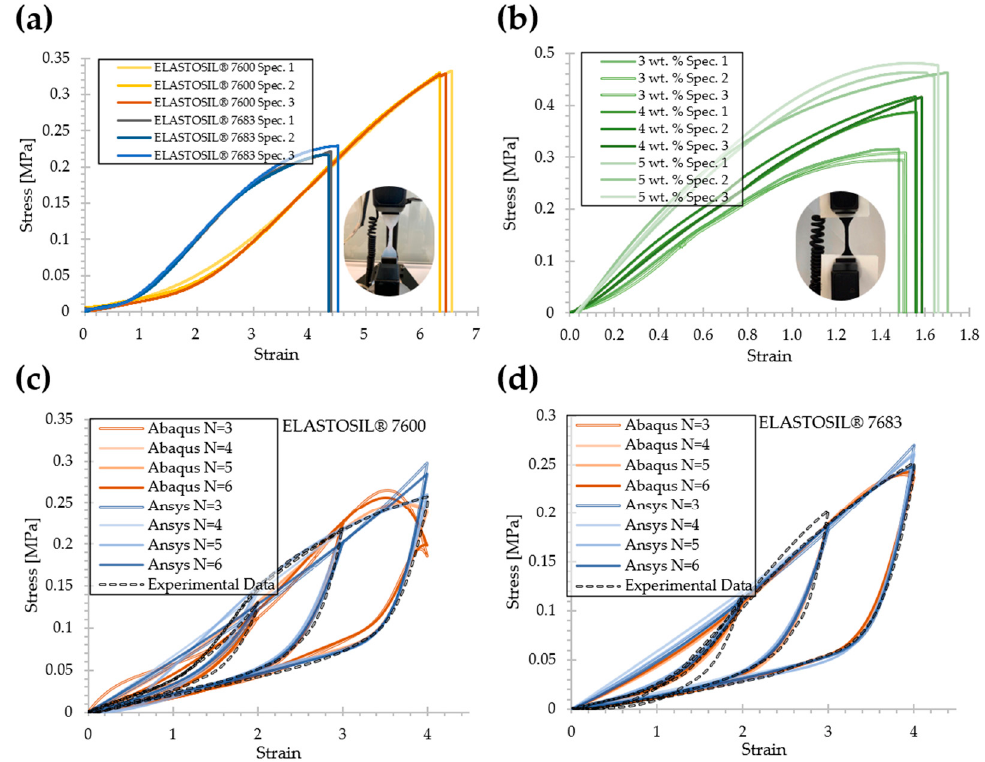
Figure 7. ( a ) Stress-strain curves of uniaxial tension test subjected to quasi-static axial loads of RTV-2 material and ( b ) RTV-2-based nanocomposite filled with different concentrations of SWCNTs; hysteresis curves of uniaxial stress loading and unloading on material ELASTOSIL ® 7600 ( c ) and 7683 ( d ).